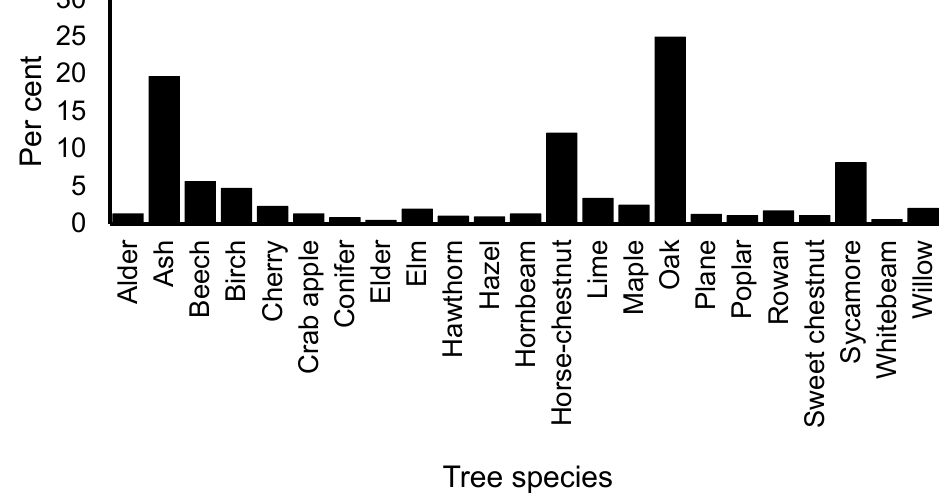
Figure 2. Range and frequency of tree species recorded in the UK OPAL tree health survey.